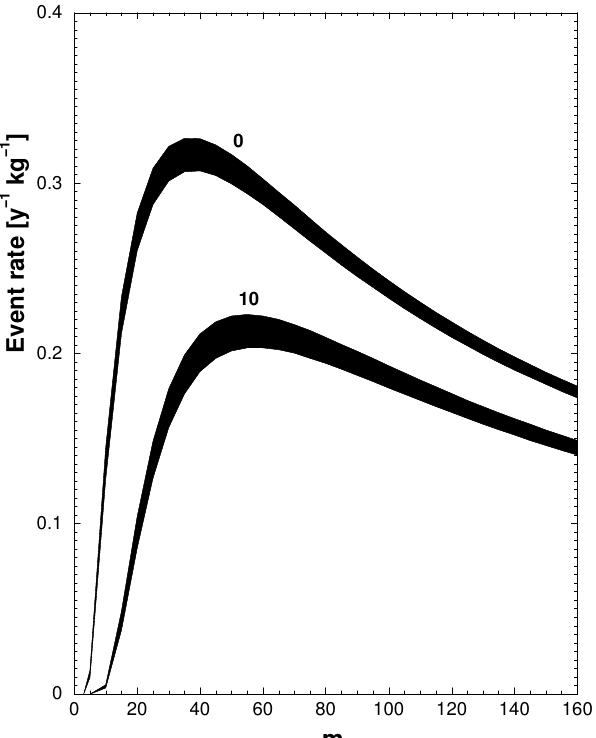
Figure 12. The event rates in units of y − 1 kg − 1 as a function of dark matter mass m χ in GeV for 40 Ar at detector threshold Q th = 0,10 keV The thickness of the curves represent the annual